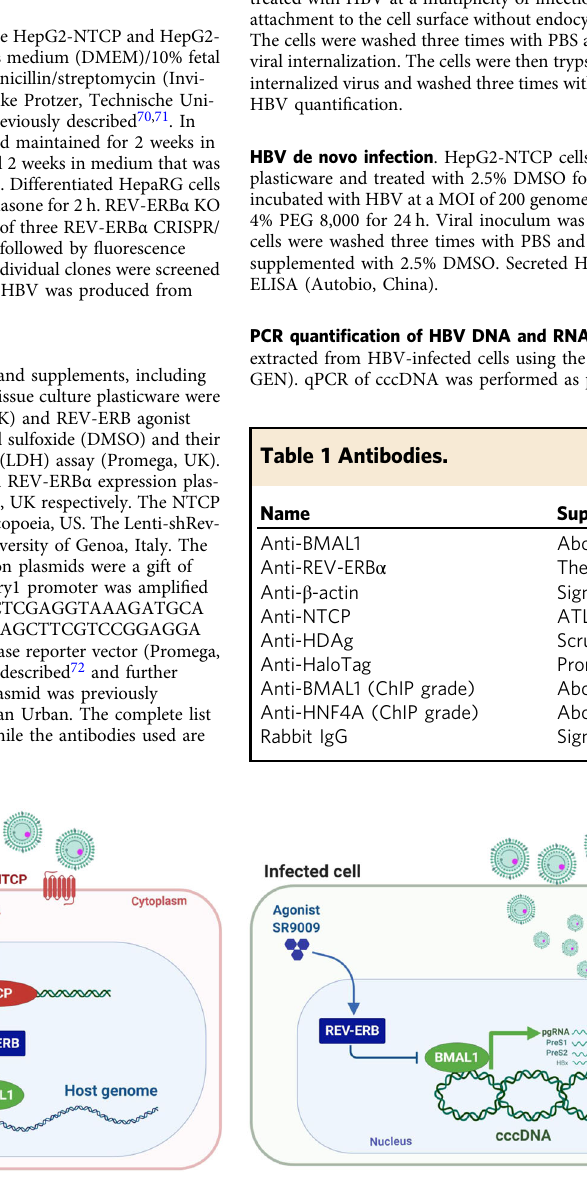
Fig. 7 Model of circadian clock component REV-ERB and BMAL1 regulating HBV life cycle. The circadian repressor REV-ERB regulates HBV and HDV entry into hepatocytes through modulating viral receptor NTCP expression. BMAL1 binds the HBV genome and promotes transcription and particle genesis. Activating REV-ERB with synthetic agonists or protein overexpression inhibits BMAL1 and represses HBV